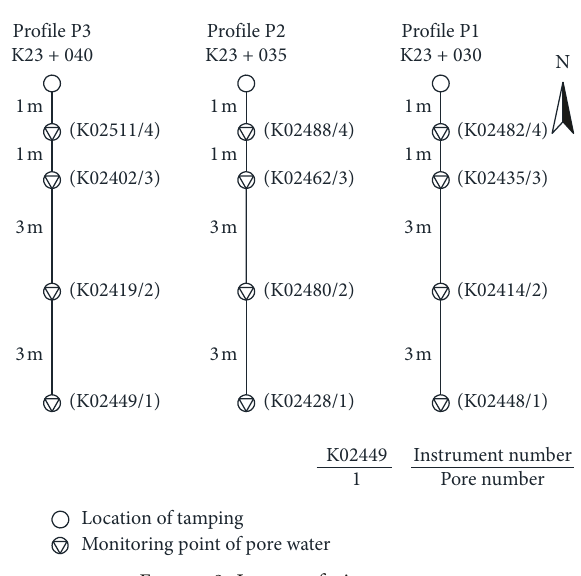
Figure 9: Layout of